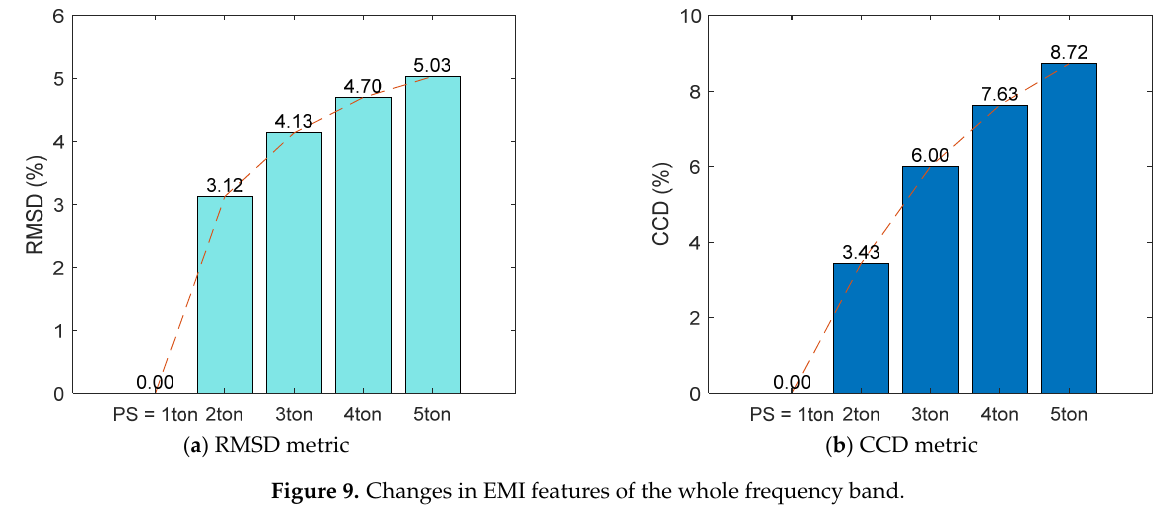
Figure 9. Changes in EMI features of the whole frequency band.